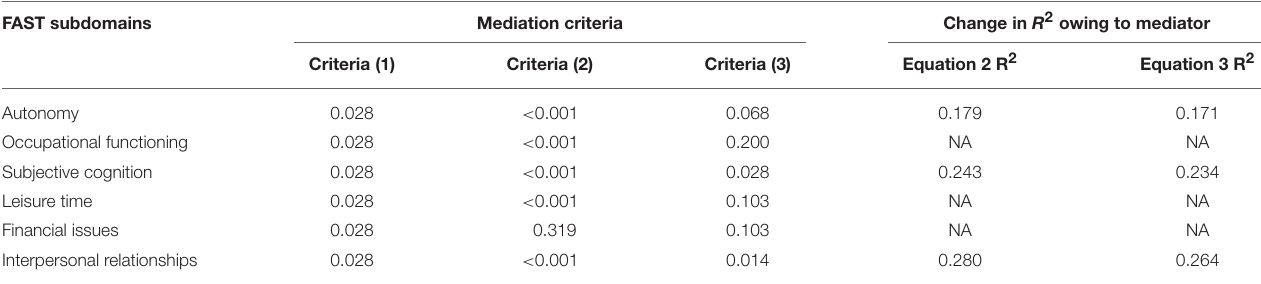
TABLE 3 | P- values for mediation criteria, and R 2 values, for the MDD status-FAST Subdomain relationship as mediated by spatial cognition ( N =